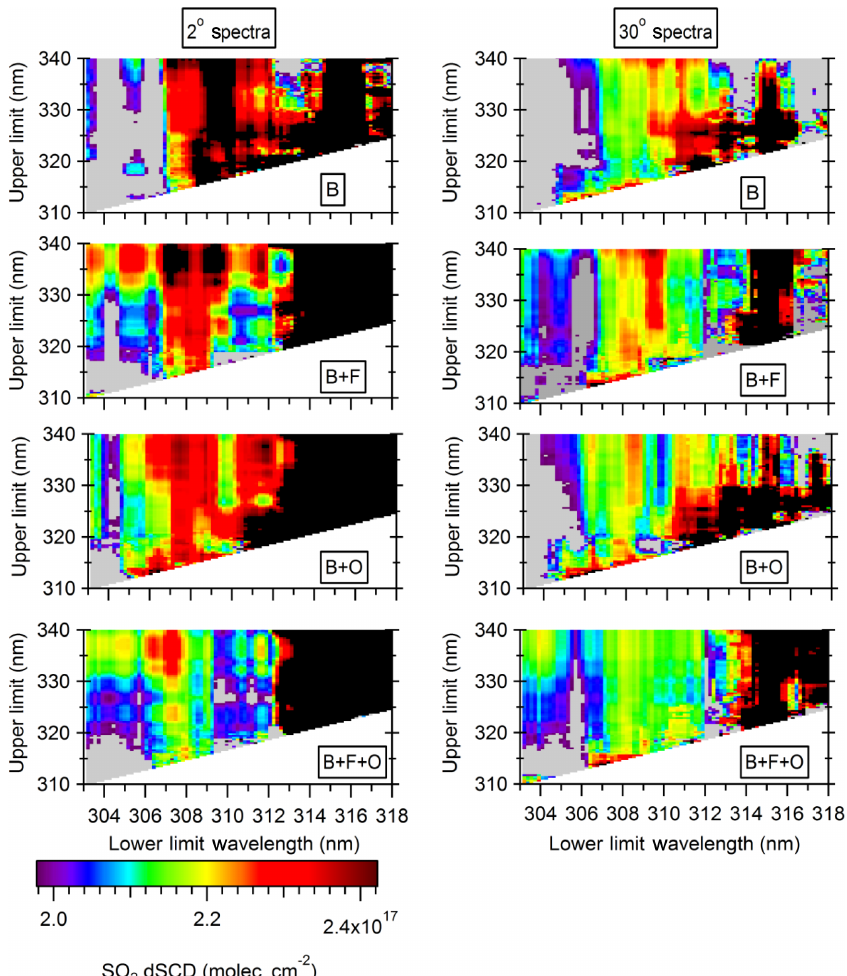
Figure 2. The SO 2 dSCDs’ fit from higher concentration measurements at 2 ◦ (left column) and 30 ◦ (right column) elevation angles for the base case, B; with the offset, B + O; with the filter, B + F; and with the filter and offset, B + F + O. Grey and black areas indicate that dSCDs were >10% less and >10% more than the expected value, respectively. The true value of the cell is 2 . 2 × 10 17 molec.cm − 2